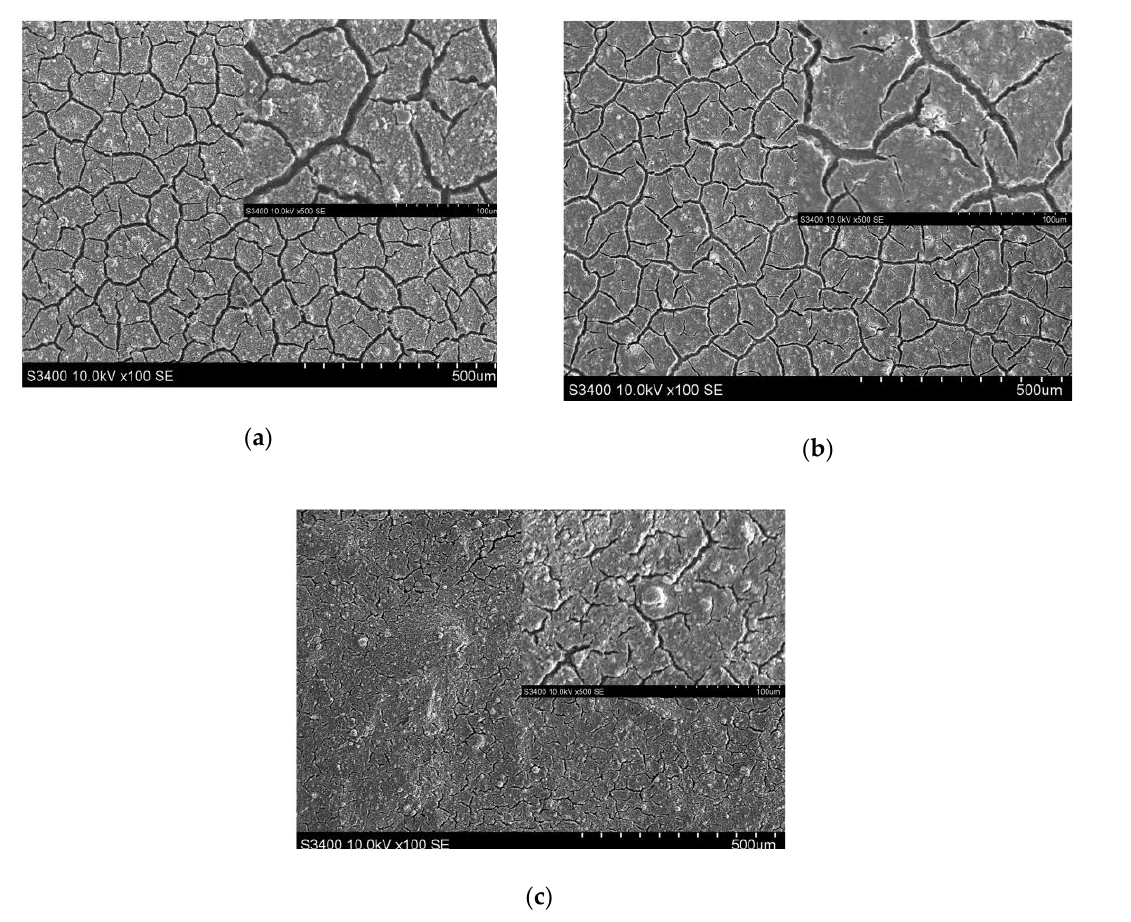
Figure 2. SEM images corresponding to ( a ) Ti_G sample annealed at 500 °C; ( b ) Ti_FTO sample annealed at 500 °C, and ( c ) Ti_Al sample annealed at 200 °C (inset shows SEM images at higher resolution corresponding to the same samples in the respective images).